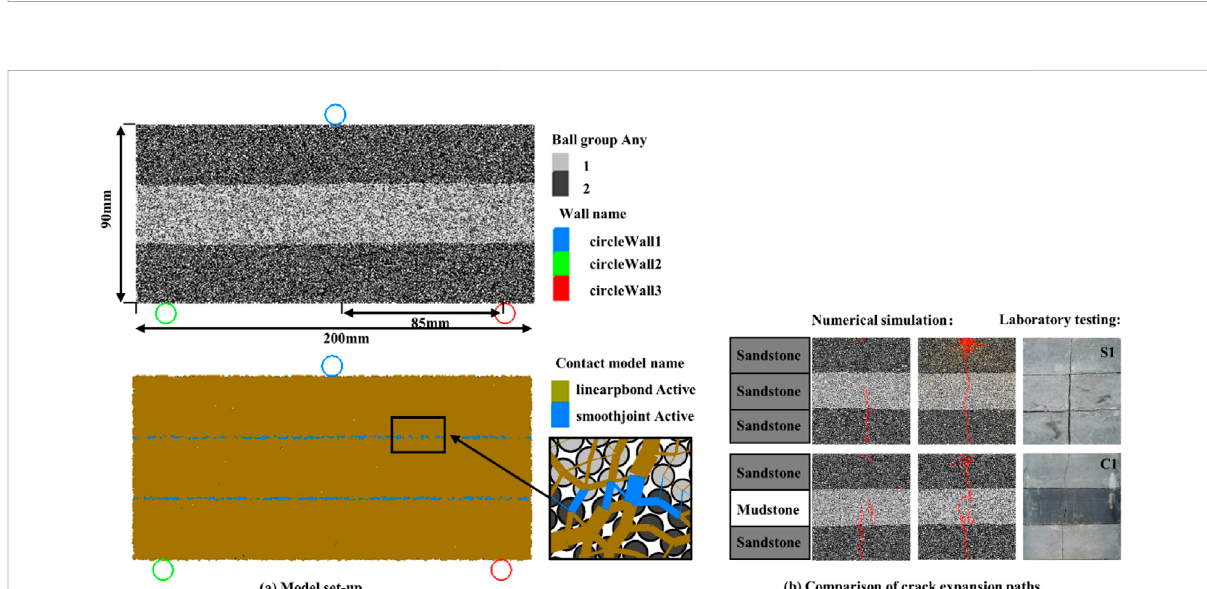
FIGURE 9 Numerical modeling. (A) Model set-up. (B) Comparison of crack propagation paths in numerical simulations and physical experiments.